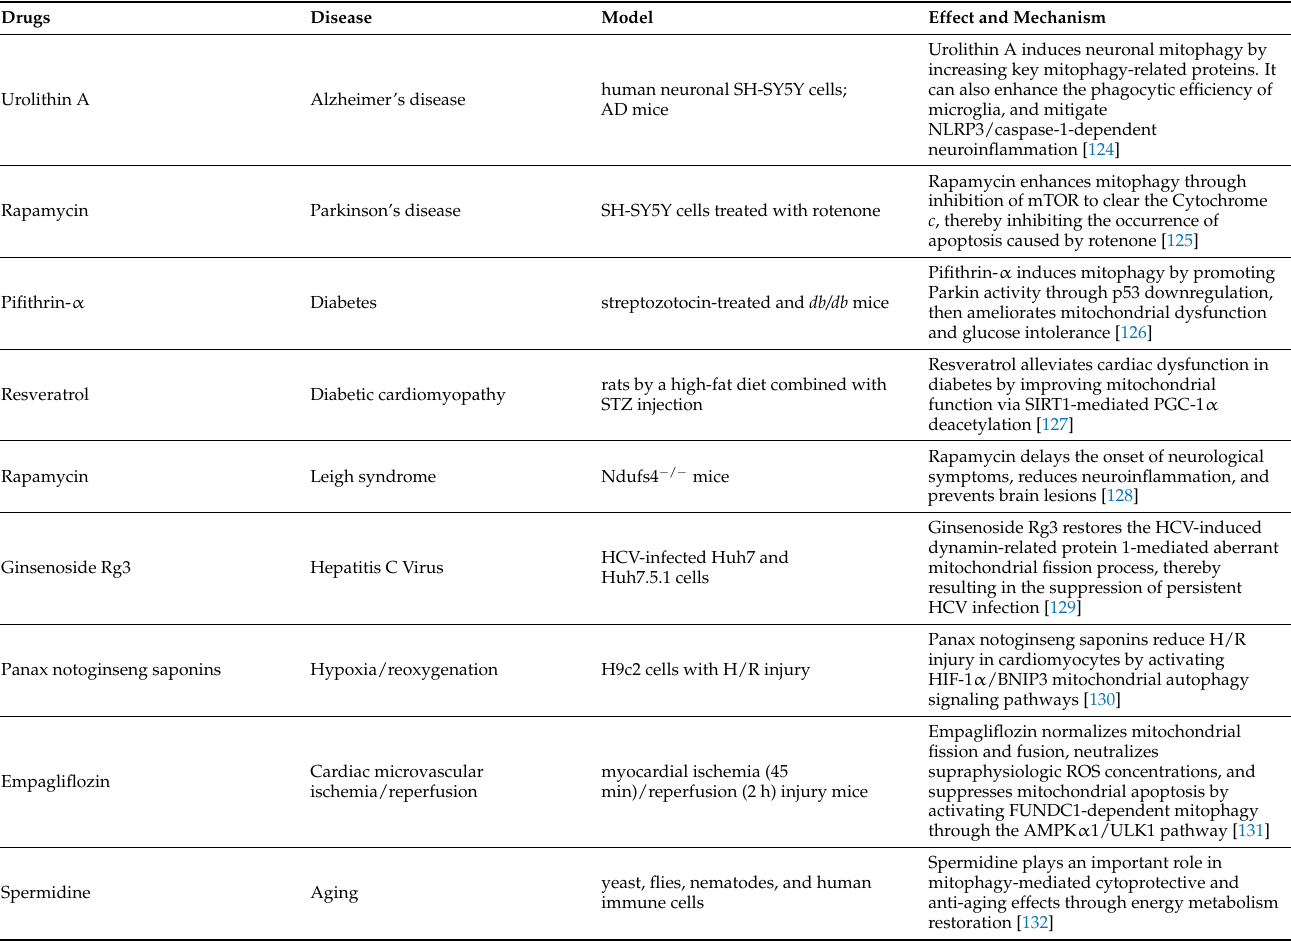
Table 1. Effect and mechanism of the candidate drugs in human